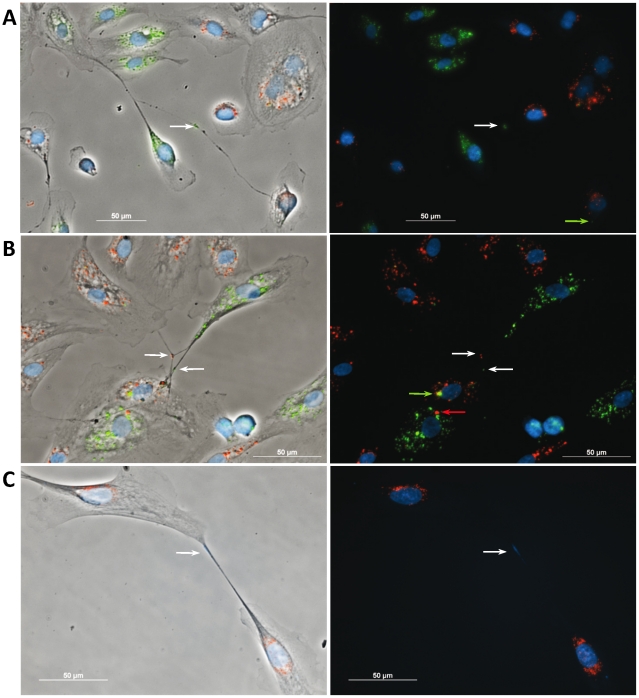
Tracing intercellular exchange by Qdot® nanocrystals.(A–C), RPTEC were labeled with either Qtracker 605 (red) or 525 (green) and co-cultured for 24 h. To-Pro-3 was used to stain the cell nucleus (DNA, blue). Fluorescence microscopy revealed a number of “double positive” cells suggesting spontaneous intercellular exchange of cytoplasmic material between the RPTECs. Fluorescence particles were also detected in the lumen of the tubular structures (arrows) indicating endoluminal transport. Among the specific morphological features of RPTEC tubes as compared to classical TNTs are their larger caliber, their ability to bridge very long distances (>200 µm) and the more frequent appearance of bifurcations or connections of multiple cells (A and B). Occasionally To-Pro-3 positive DNA-signal (blue staining) was detected in the lumen of the tubes (C) suggesting the possibility of the exchange of genetic material between RPTEC.